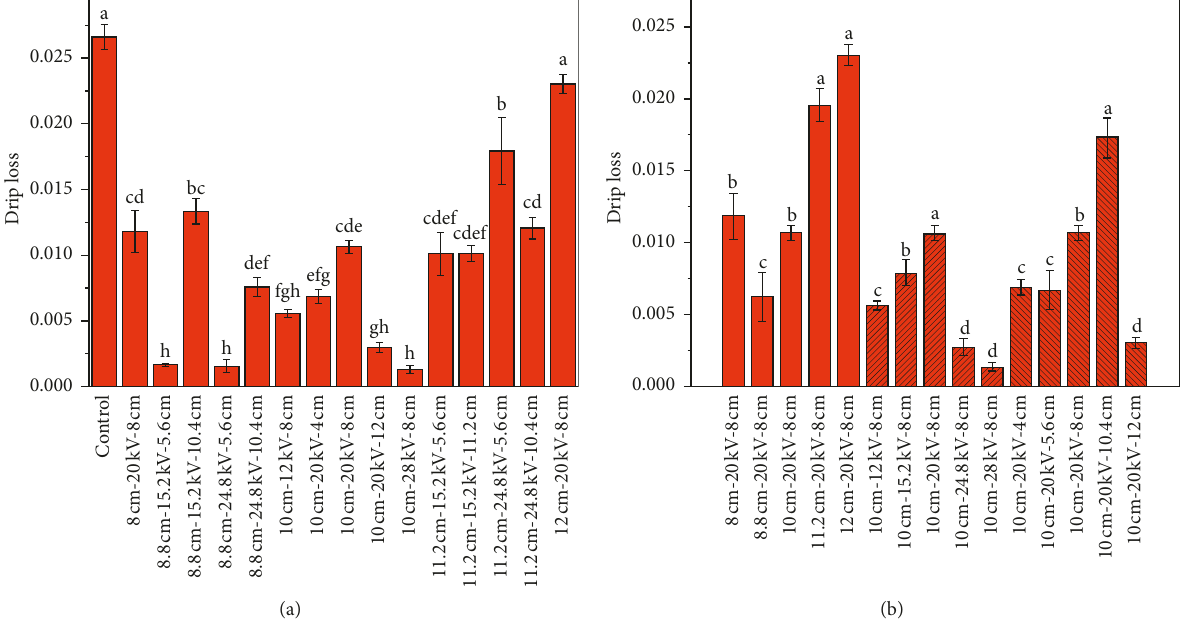
Figure 3: Effect of different treatments on drip loss. (a) The response surface methodology; (b) the single electric parameter analysis. Data are shown as the mean ± SD for each response. For each response, means with different lowercase letters are significantly different ( p < 0 . 05). The order of the parameters is electrode distance, voltage, and needle